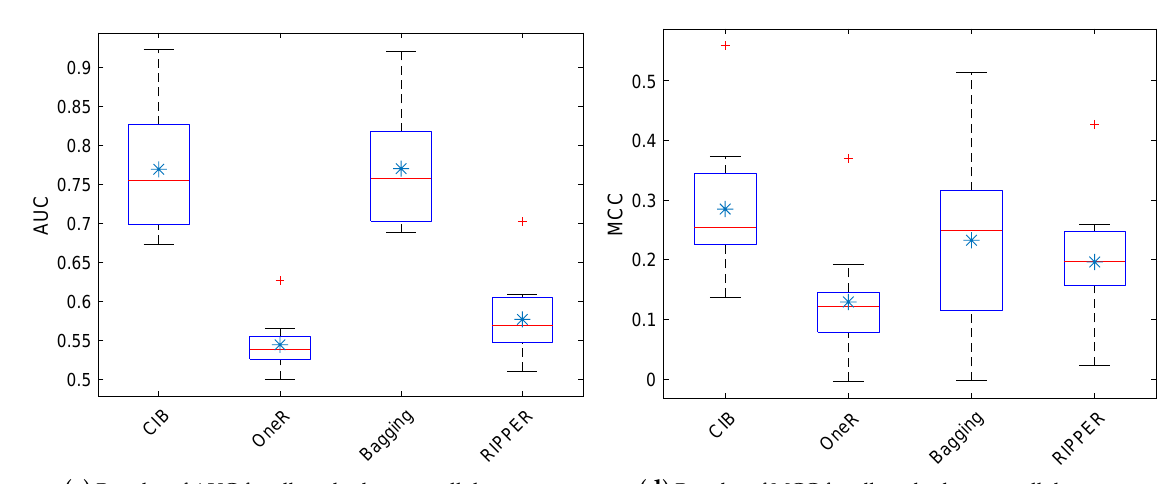
( b ) Boxplot of AGF for all methods across all datasets.